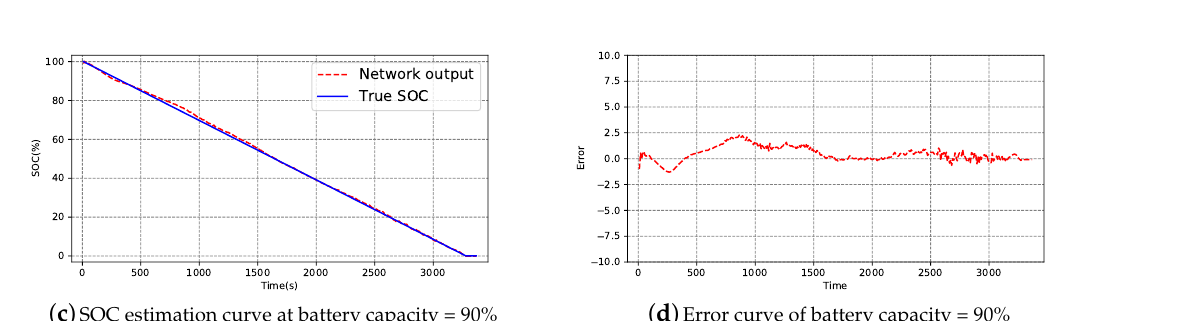
( b ) Error curve of discharge battery capacity = 95%